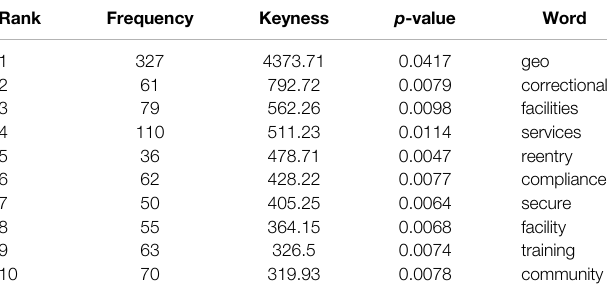
TABLE 4 | Keywords of the GEO corpus in comparison to the oANC. Rank Frequency Keyness p -value